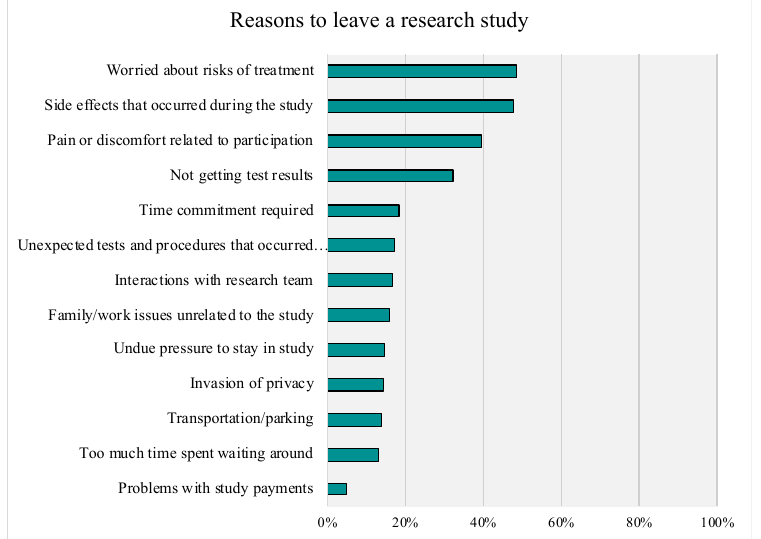
Figure 6. Reasons for Withdrawing from a Research Study. Top Box Responses (“Very Important”) are Presented.